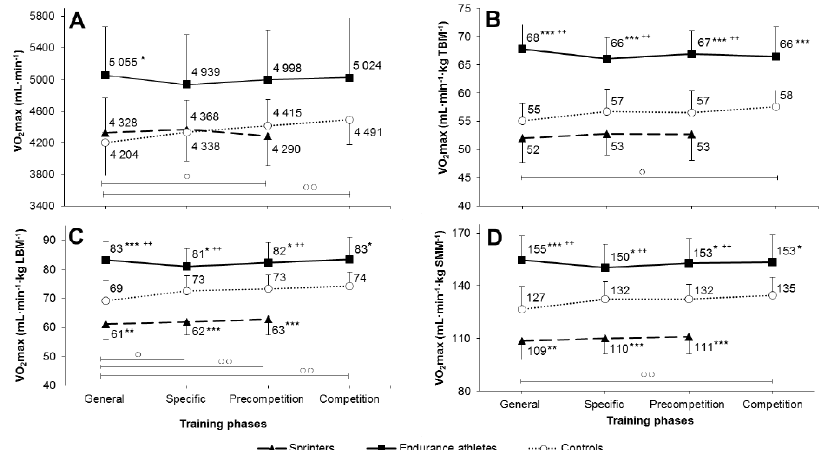
Figure 2. Changes in maximal oxygen uptake ( V̇ O 2 max) between consecutive phases of the annual training cycle in athletes and controls. ( A ) — absolute values; Panel ( B ) — calculated per weight or kilogram of total body mass (TBM); Panel ( C ) — calculated per kilogram of lean body mass (LBM); Panel ( D ) — calculated per kilogram of skeletal muscle mass (SMM.) ○ p < 0.05, ○○ p < 0.01 — significantly different from the general preparation phase in the control group; ++ p < 0.01 — significantly different from sprinters at the same training phase; # p < 0.01 — significantly different from endurance athletes at the same training phase; * p < 0.05, ** p < 0.01, *** p < 0.001 — significantly different from controls at the same training phase.